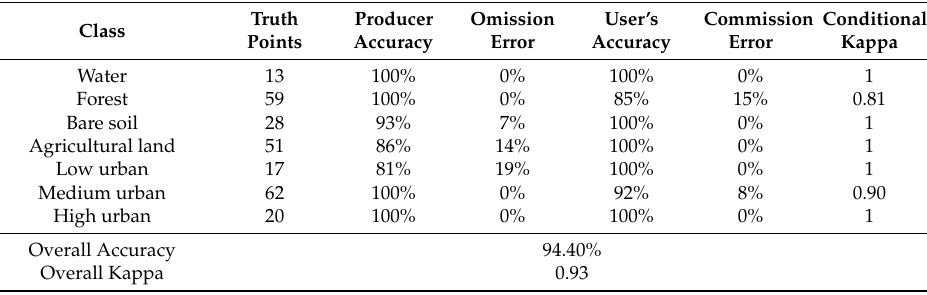
Table 2. Accuracy assessment for the classification of the 2007 image.